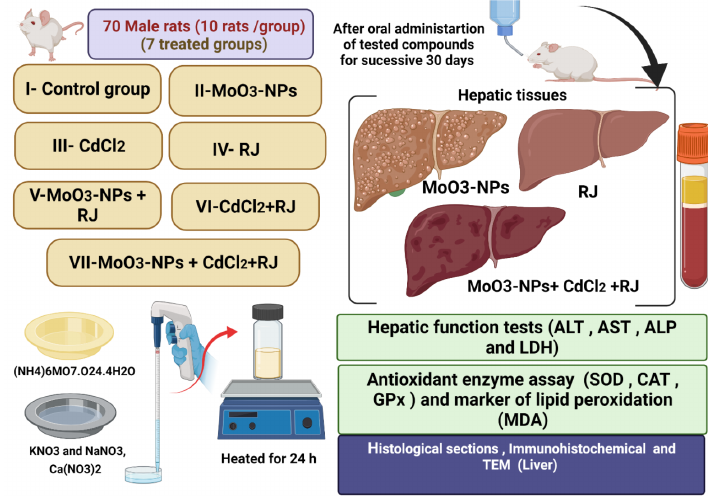
Figure 1. Schematic representation of the experimental